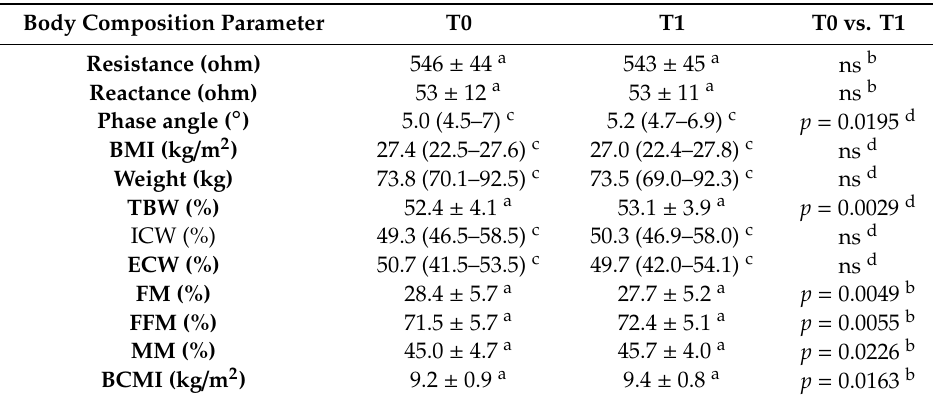
Table 9. Body composition parameters of healthy subjects.